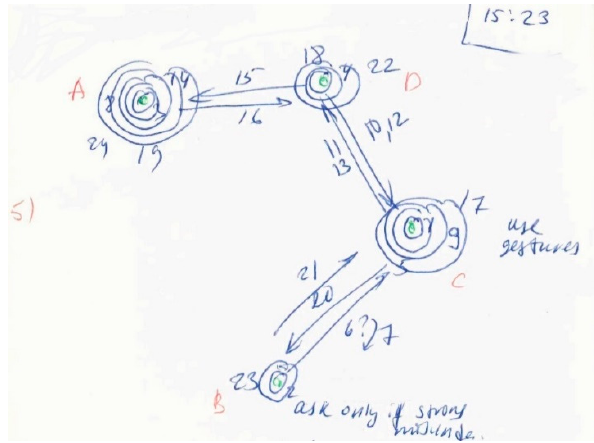
Figure 2. Example of grounding process in a project meeting (participants B and C), represented as an interaction diagram.